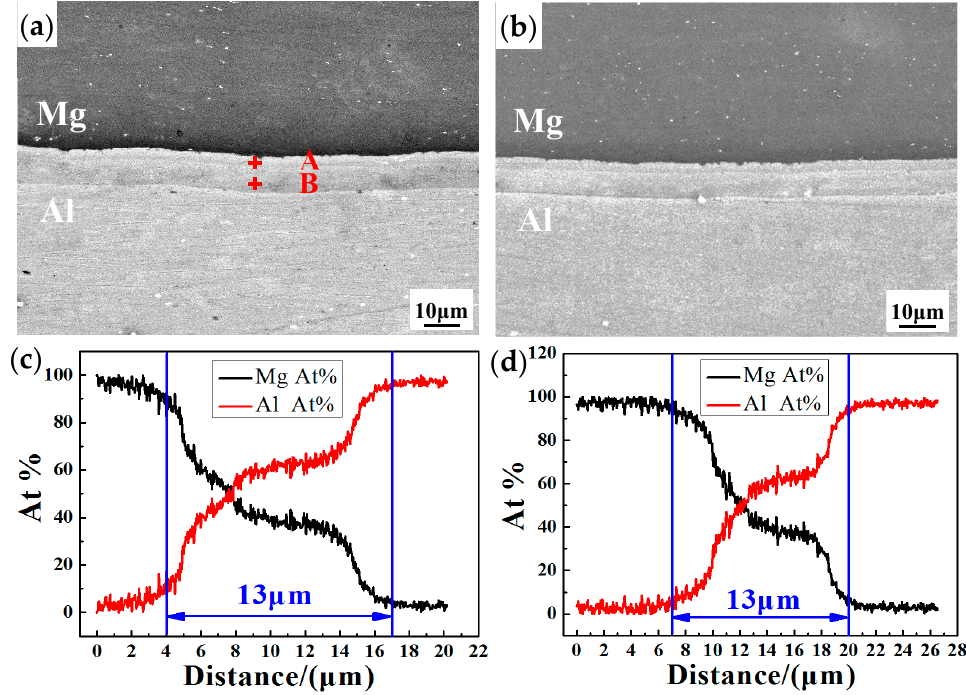
Figure 6. SEM micrographs of the intermediate heating process at 400 °C for 5 min: ( a , c ) RD; ( b , d ) TD.